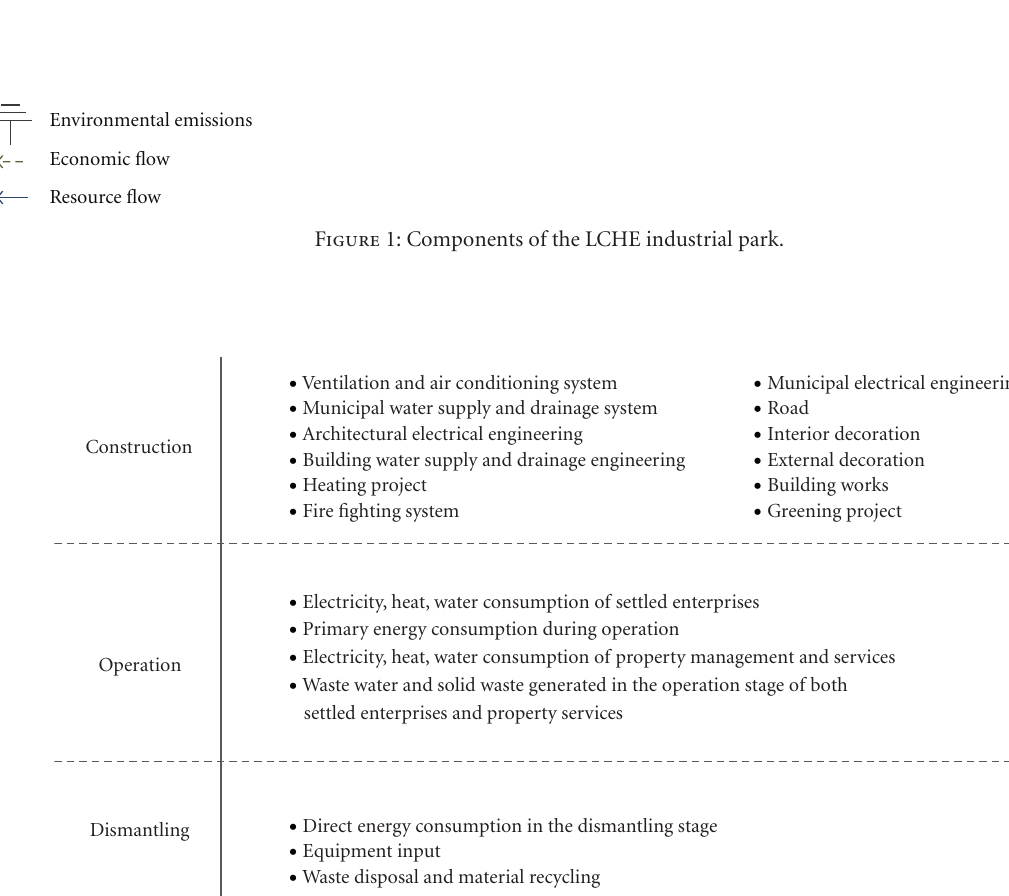
Figure 2: System boundary of sustainability